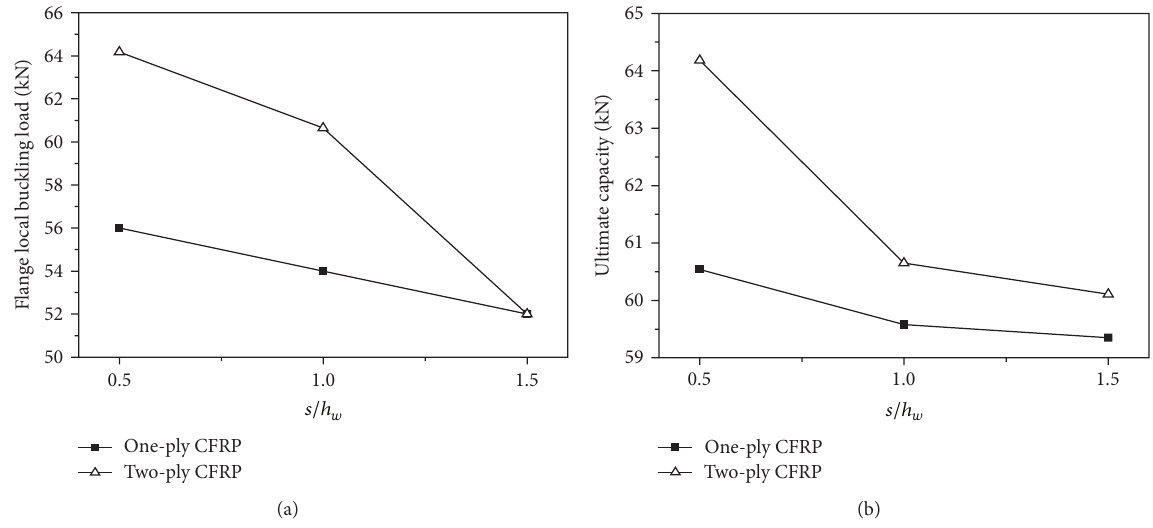
Figure 8: The relationship of buckling load capacity and 𝑠/ℎ 𝑤 ratio.